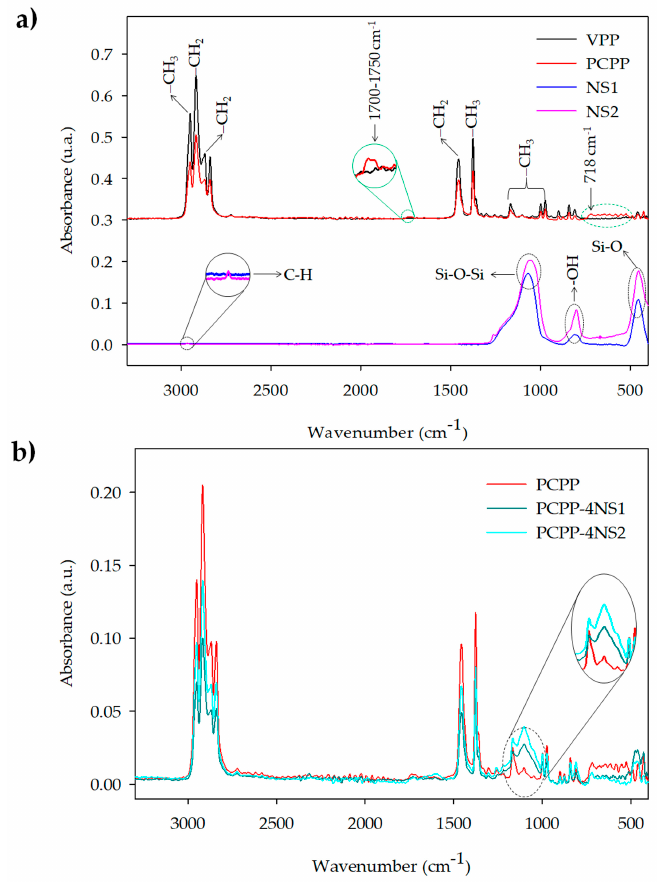
Figure 1. ATR-FTIR spectra of ( a ) VPP, PCPP, NS1 and NS2 and ( b ) representative developed nano-composites.